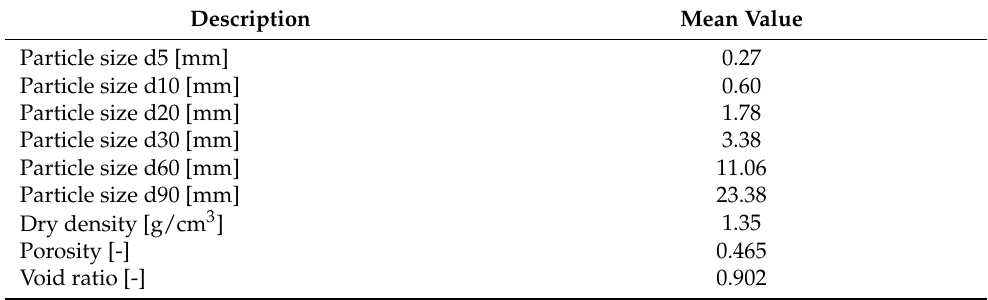
Table 1. Average values of parameters of physical properties of materials.